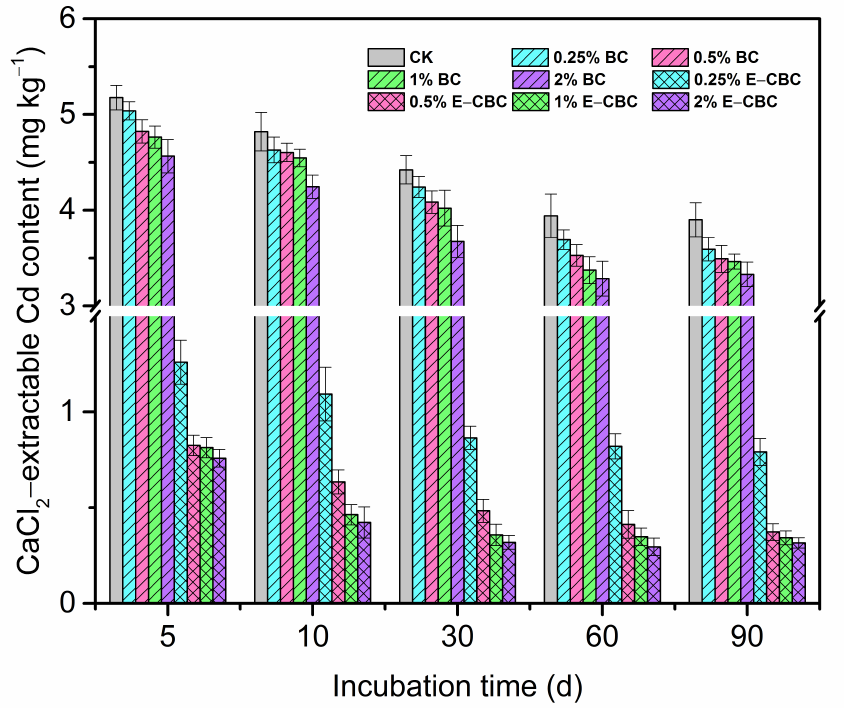
Figure 4. Effects of BC and E–CBC on the bioavailability of Cd in soil.